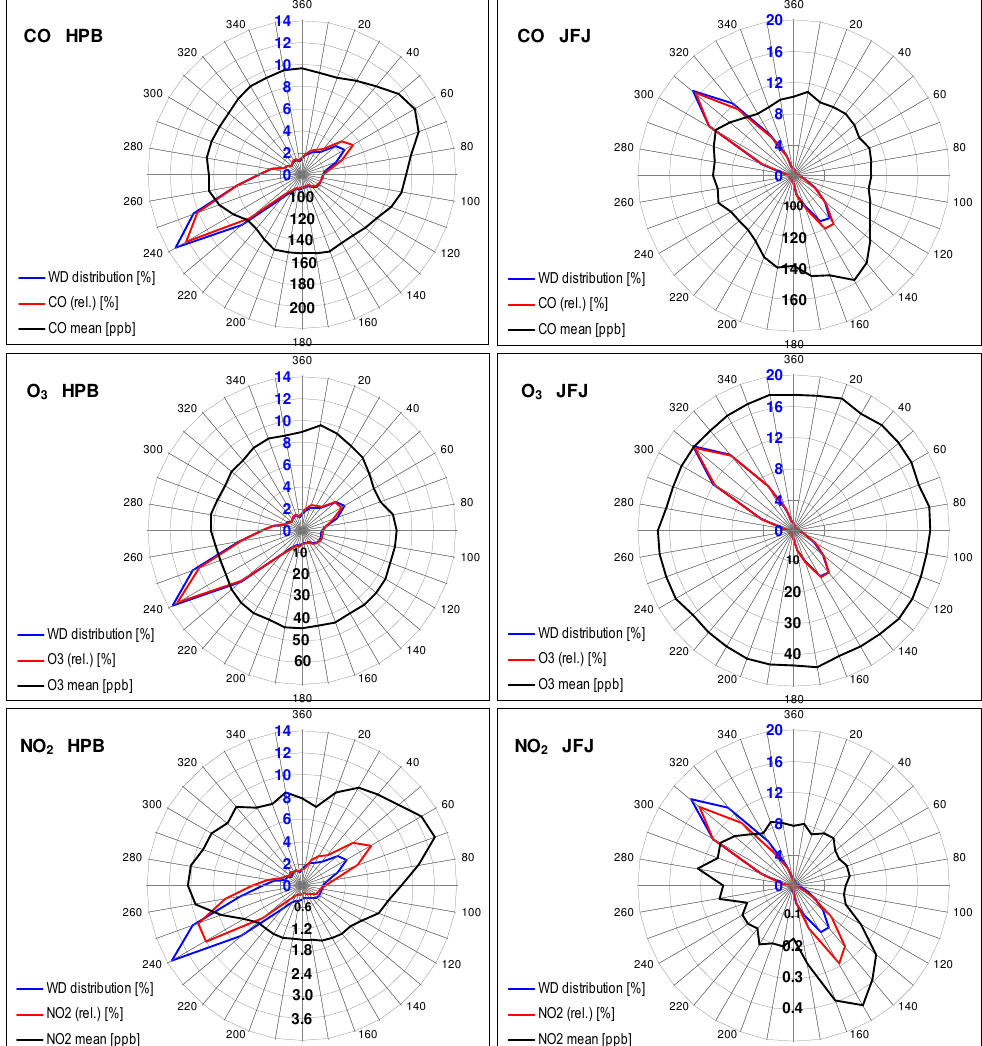
Figure 16. Dependence of CO, O 3 , NO 2 on wind direction for station HPB (left column) and JFJ (right column): Mean of respective trace gas per 10 ◦ wind direction interval (black), relative frequency of wind direction (blue) and relative abundance of the respective trace gas, weighted by frequency of wind direction (red). The latter one is calculated by first multiplying the respective mean mixing ratio and the wind frequency in a given 10 ◦ sector, and then normalizing these numbers by the corresponding integral over all wind sectors.